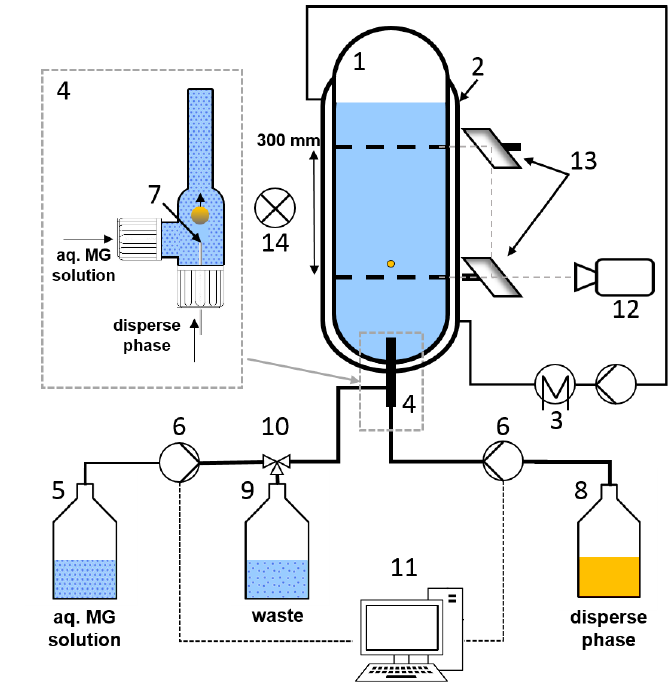
Figure 2. Experimental setup. (1) glass column, (2) jacket, (3) thermostat, (4) drop generator unit, (5) aq. microgel solution, (6) dosing system, (7) nozzle, (8) disperse phase, (9) waste, (10) three way valve, (11) computer control, (12) camera, (13) mirror, (14)